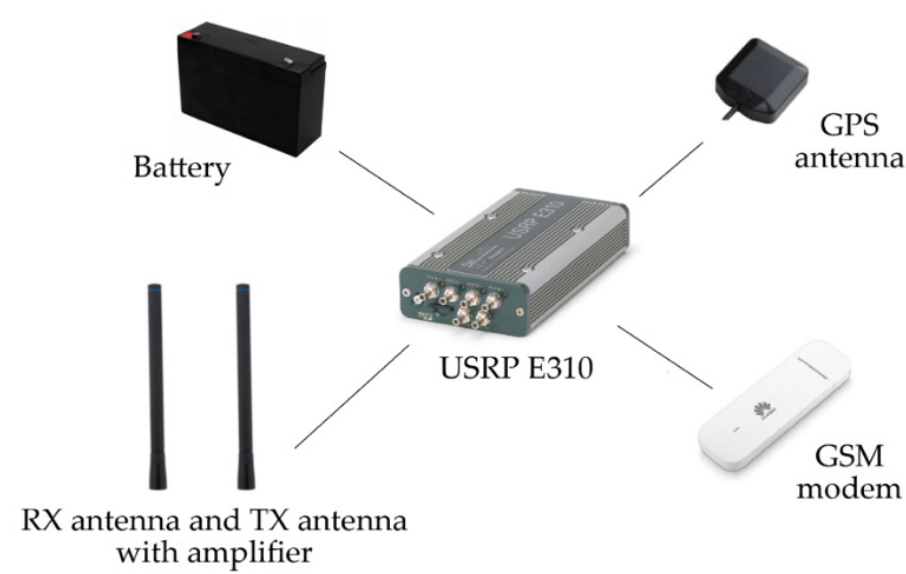
Figure 11. Testbed architecture.